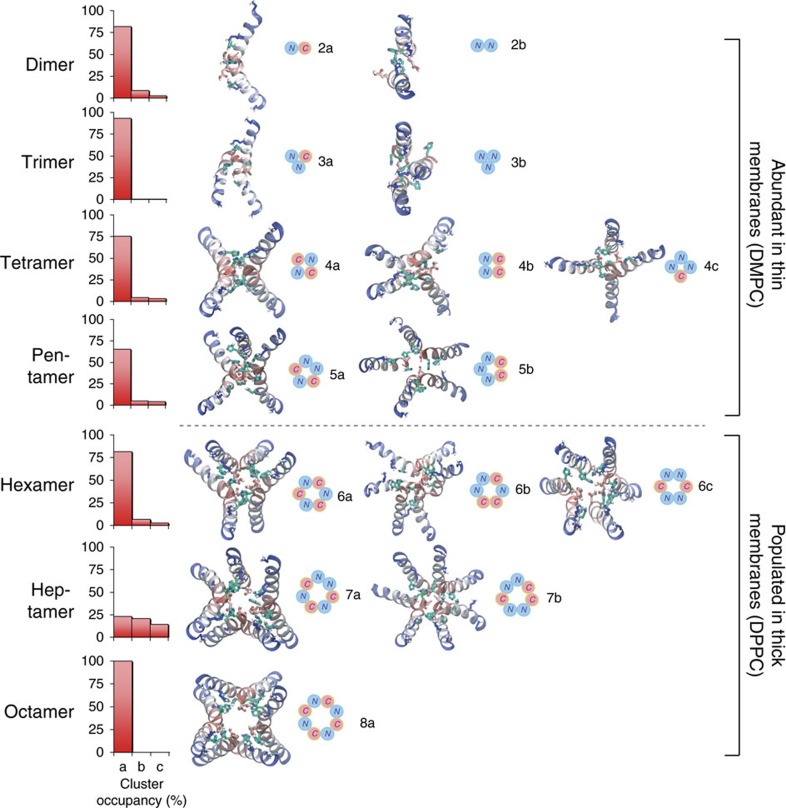
Pore ensemble structure variation.Oligomeric channel-like structures observed in the assembly simulations, together with a corresponding top-view assembly scheme show the versatility of the structural arrangement of the peptides (N: N terminus up, C: C terminus up). The symmetric antiparallel arrangements, assembled from antiparallel peptide pairs (dimer 2a is the basic building block) are always the most populated cluster for each oligomer (cluster ‘a'). Membrane thickness can markedly influence the architecture of the TM oligomers formed by maculatin. In thin membranes (for example, 1,2-dimyristoyl-sn-glycero-3-phosphocholine; DMPC) only oligomers with a small number of peptides are formed. Oligomers with more than five peptides are found only in thicker membranes (1,2-dipalmitoyl-sn-glycero-3-phosphocholine; DPPC), where peptides tilt less, with the octamer forming the largest pore.